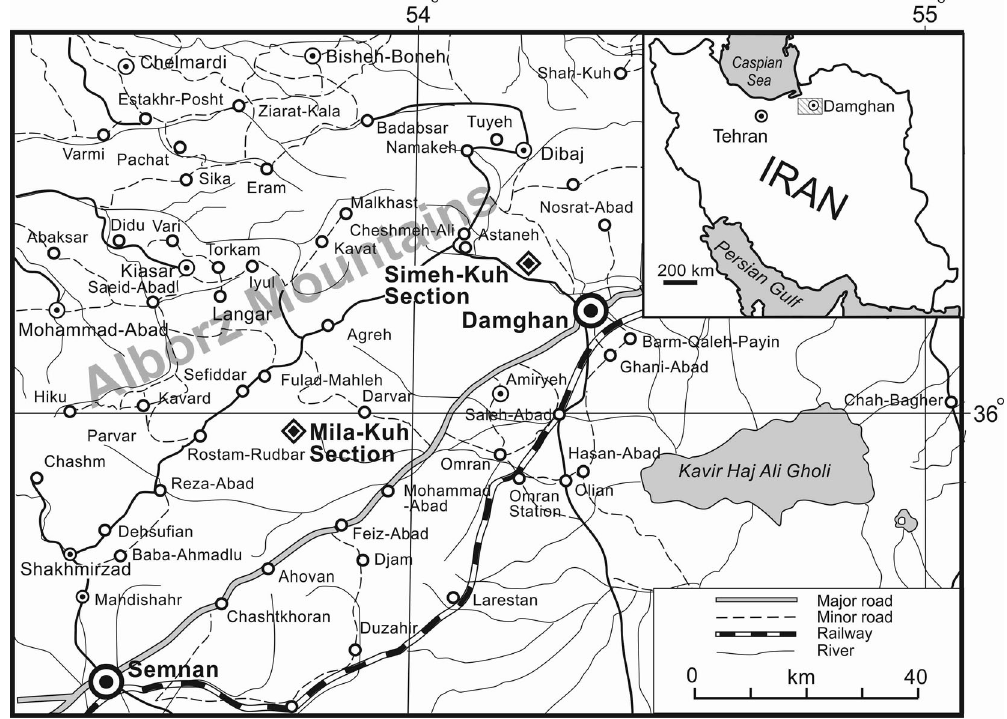
Fig. 1. Geographical map of northern Iran showing the position of the Mila-Kuh